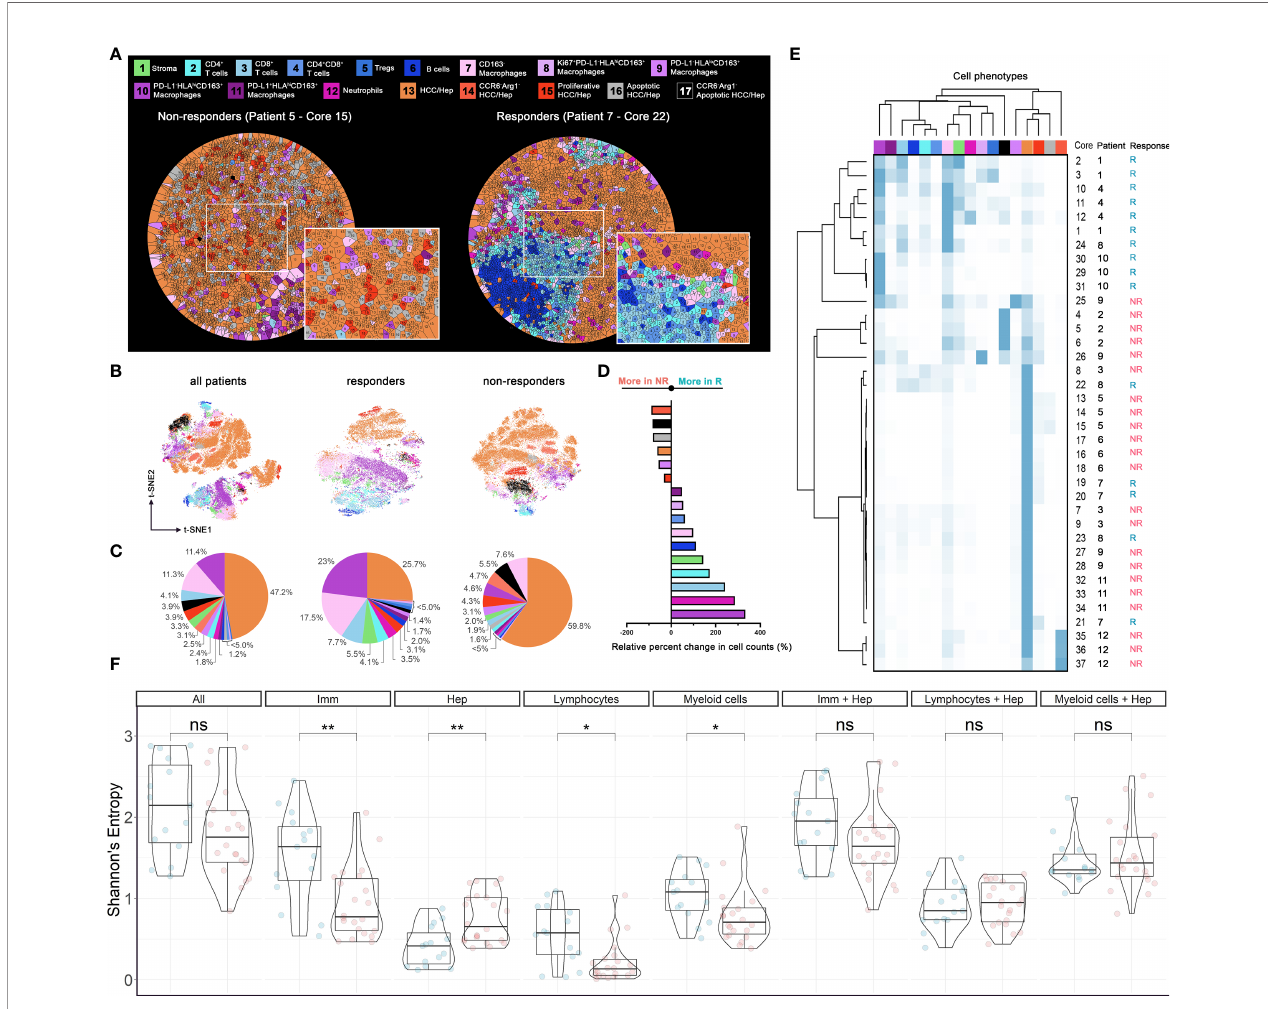
FIGURE 3 | Cell populational characteristics and heterogeneity. (A) Voronoi tessellation results for exemplar responder and non-responder cores. Each partitioned polygon was color-coded by corresponding cell type. Cell distributions evaluated using (B) t-SNE visualization (n = 58,740), (C) pie-chart, (D) waterfall, and (E) heatmap and hierarchical clustering. (F) Spatial Shannon ’ s entropy computed for different sets of cell types. Signi fi cant differences were observed for immune cell subset, tumor cell subset, lymphocytes subset, and myeloid cell subsets between responder samples (n = 15) and non-responder samples (n = 22). P values were computed using Wilcox rank-sum test and adjusted using FDR. *p value < 0.05; **p value < 0.01. ns, not signi fi